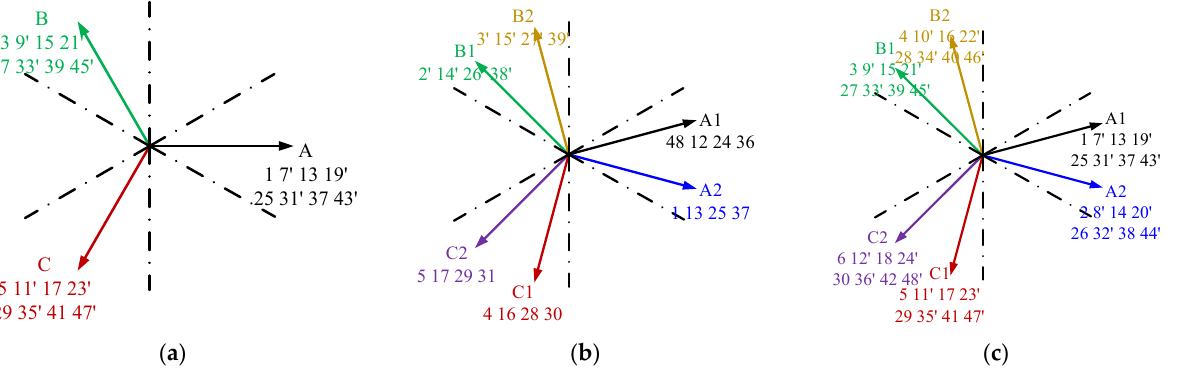
Figure 5. Coil EMF phasor diagrams of different winding configurations: ( a ) ORG; ( b ) DTP-SF; ( c ) DTP-DS.